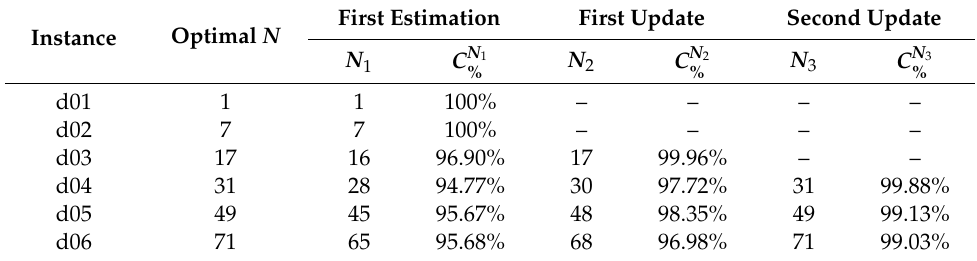
Figure 13. The progress in optimizing the number of waypoints, for instance d04: ( a ) first estimation ( N = 28); ( b ) first update ( N = 30); ( c ) second update ( N = 31). Table 6. Results of the algorithm for the optimizing the number of waypoints.